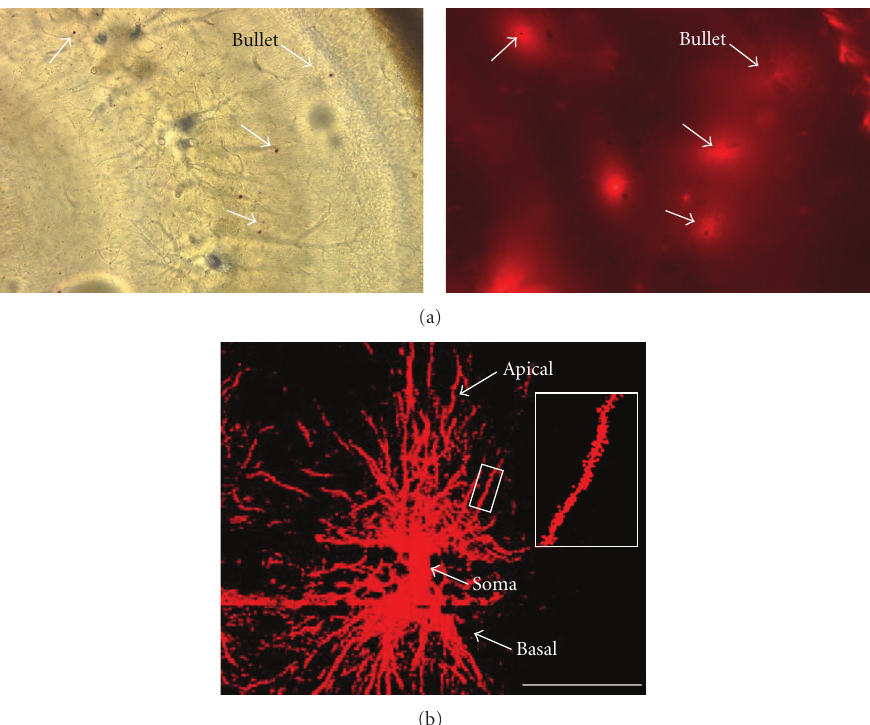
Figure 1: Dendritic spines in the CA1 region of the hippocampus visualized by DiI “DiOlistics” and confocal microscopy. (a) (left) , Brightfield image of the CA1 region of a representative formalin-fixed hippocampal section (100 µ m thickness) stained with DiI by particle- mediated labeling (DiOlistics) showing tungsten bullets used to deliver DiI (arrows). (right), DiI fluorescence from the same field of view. (b) Representative CA1 pyramidal neuron stained with DiI and imaged by confocal microscopy. Inset: apical dendritic segment representative of those selected for quantitative analyses of dendritic